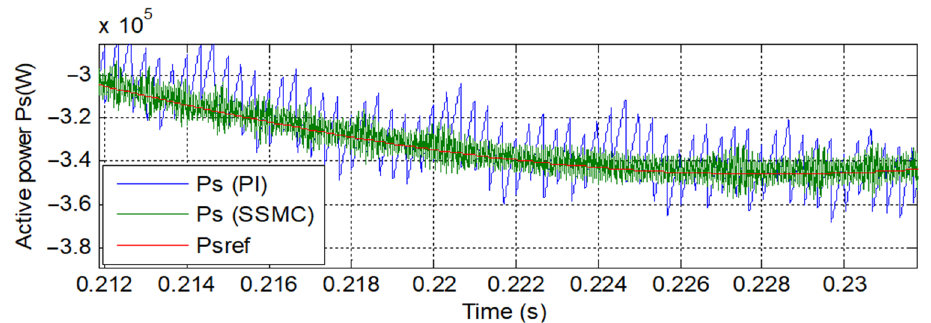
Figure 9. Stator current.